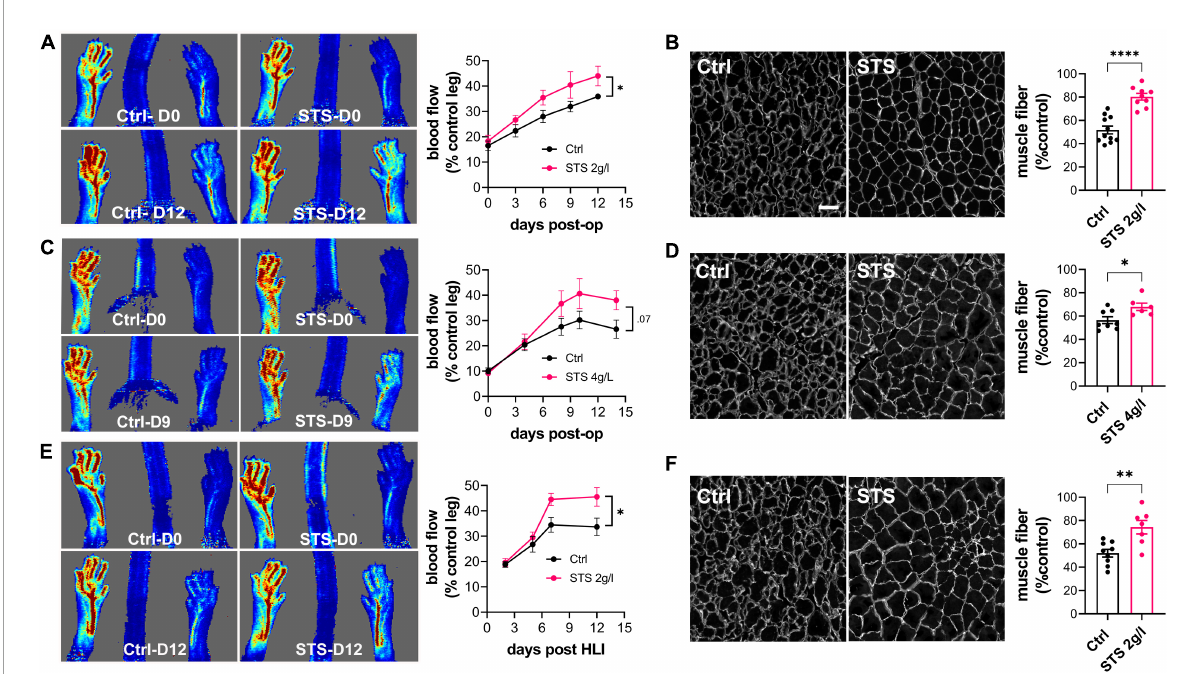
FIGURE1 Sodium thiosulfate (STS) promotes revascularization and muscle recovery in a mouse model of hindlimb ischemia. Doppler imaging (A,C,E) and laminin immunostaining in the gastrocnemius muscle (B,D,F) of WT male mice submitted to HLI and treated or not (Ctrl) with 2 g/L STS (A,B) or 4 g/L STS (C,D) , or LDLR - / - mice treated with 2 g/L STS (E,F) . (A,C,E) Data are mean ± SEM of 8–12 animals per group. * p < 0.05 as determined by repeated measures Mixed-effects model (REML). (B,D,F) Data are mean ± SEM of 6–12 animals per group. * p < 0.05, ** p < 0.01; **** p < 0.0001 as determined by bilateral unpaired t -test. Scale bar 100 µ